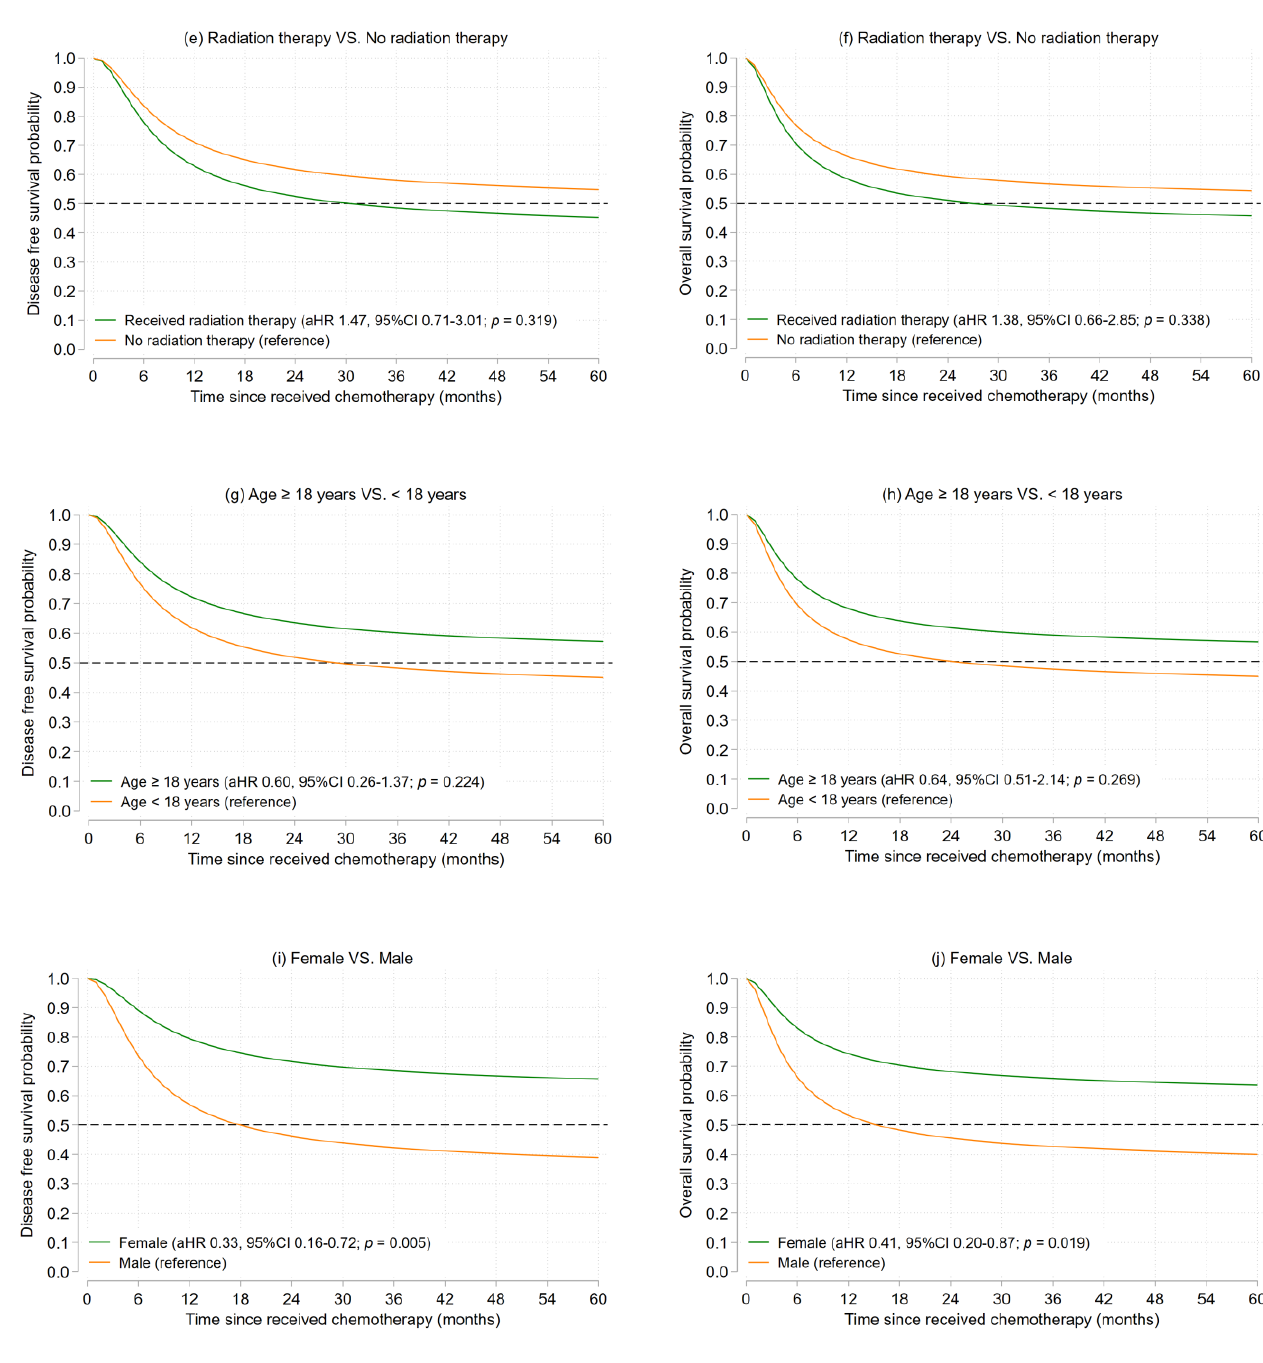
Figure 1. The estimated 5-year DFS and 5-year OS of osteosarcoma patients by the Flexible parametric survival model ( a – j